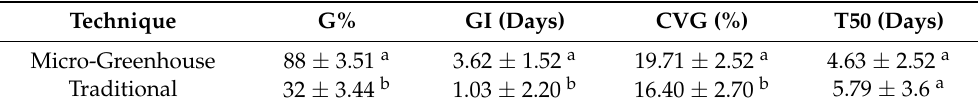
Table 5. Germination parameter results.